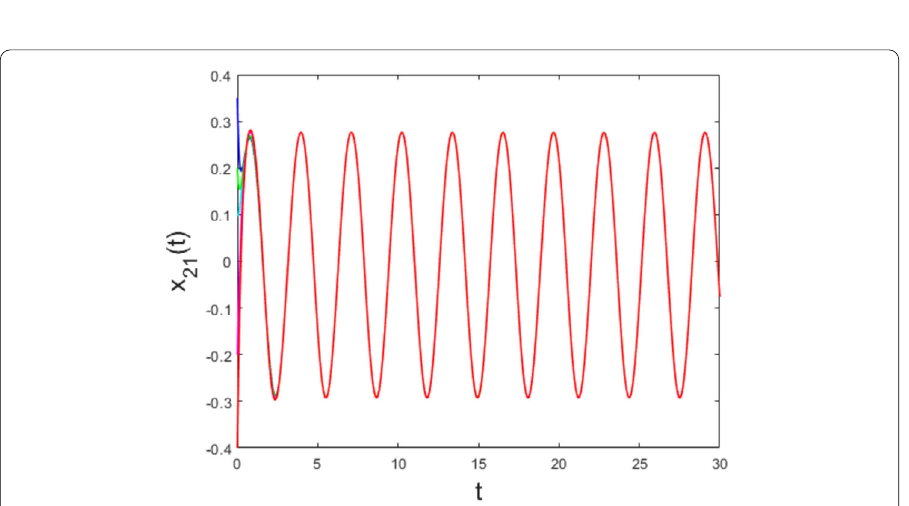
Figure 3 The state trajectory x 21 ( t ) of the network (11) with the initial conditions x 21 ( t ) = –0.4,–0.2,0.1,0.2,and 0.3for t ∈ [–1,0]. It is seen that the FSICNN (11) has a globally exponentially stable π -periodic